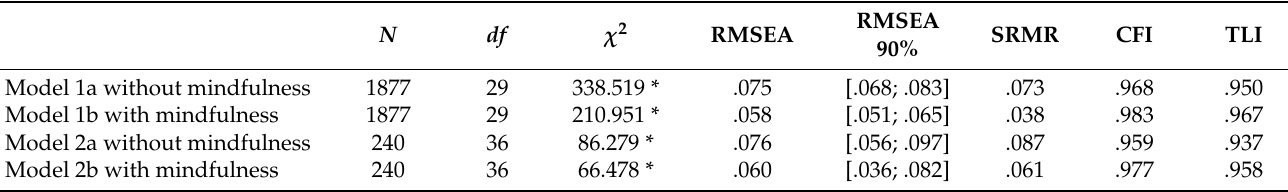
Table 2. Model fit indices of the four path models.